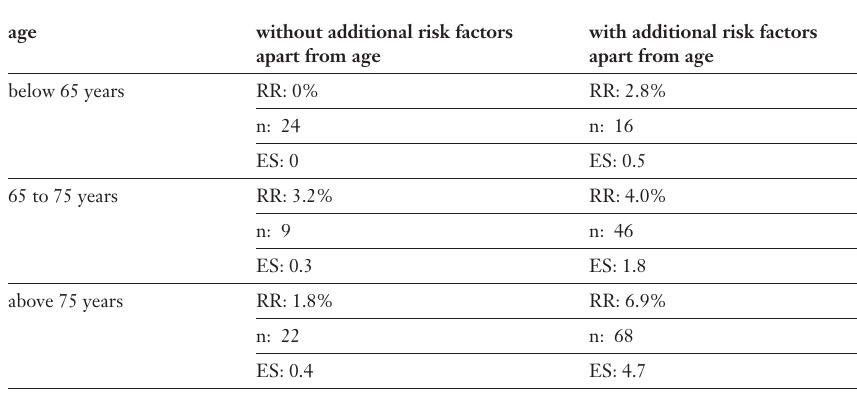
without additional risk factors